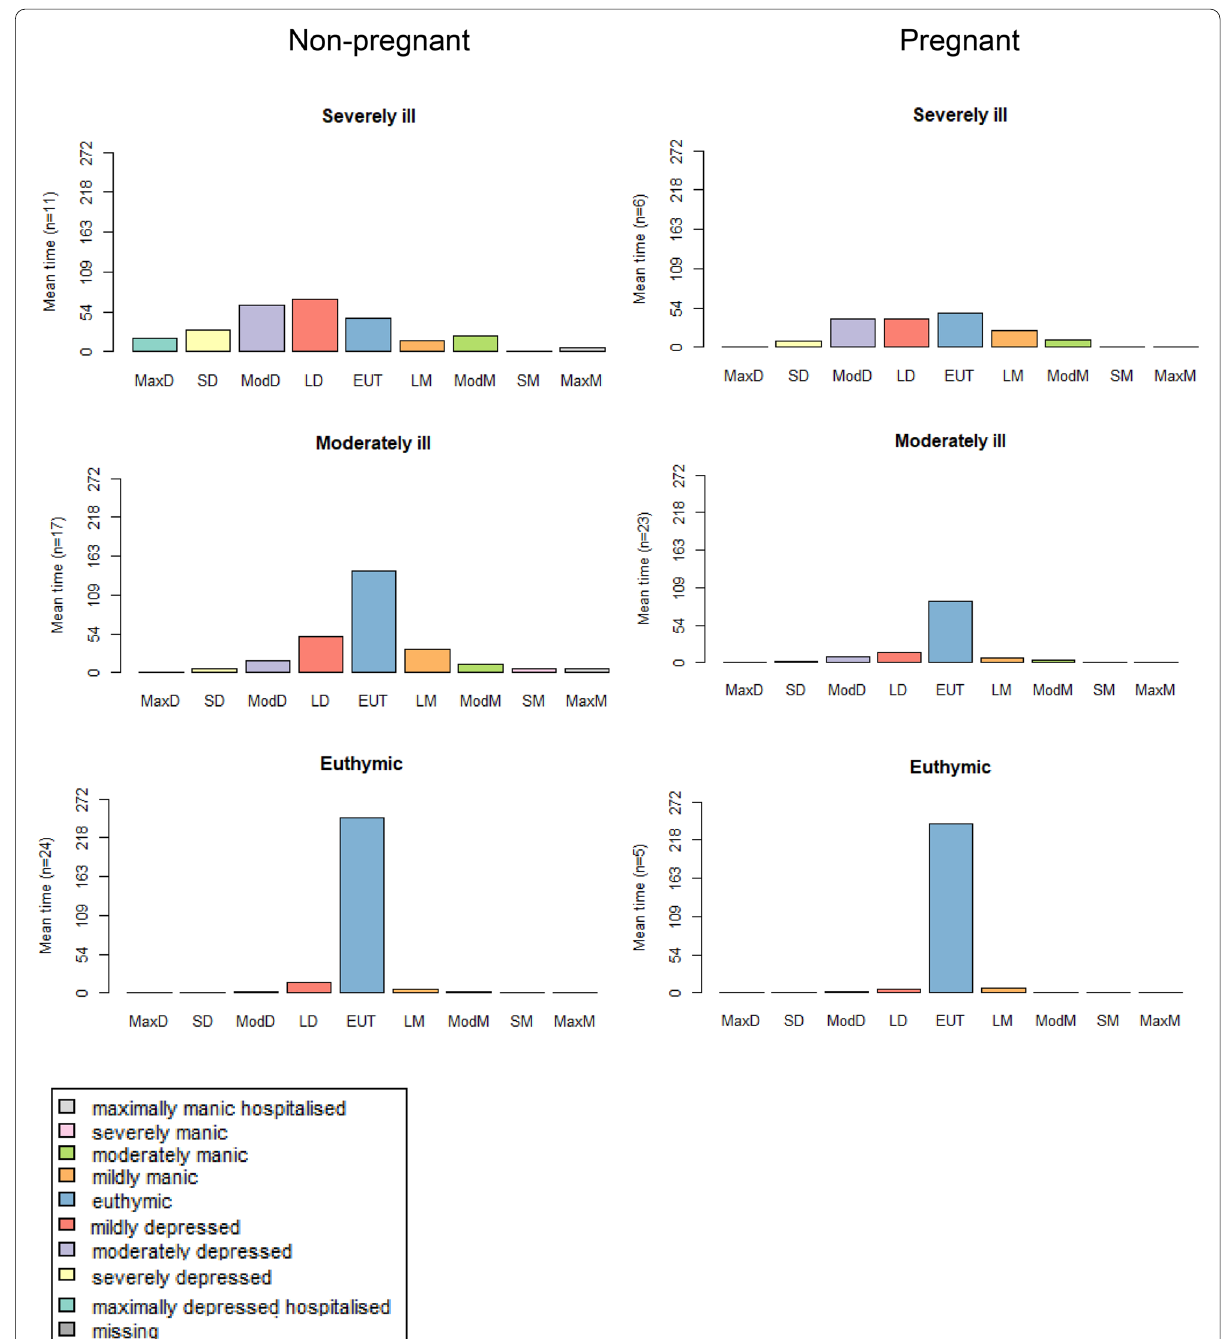
Fig. 3 Mean time (in days) spent in each state for three clusters, pregnant women on the left, non‑pregnant women on the